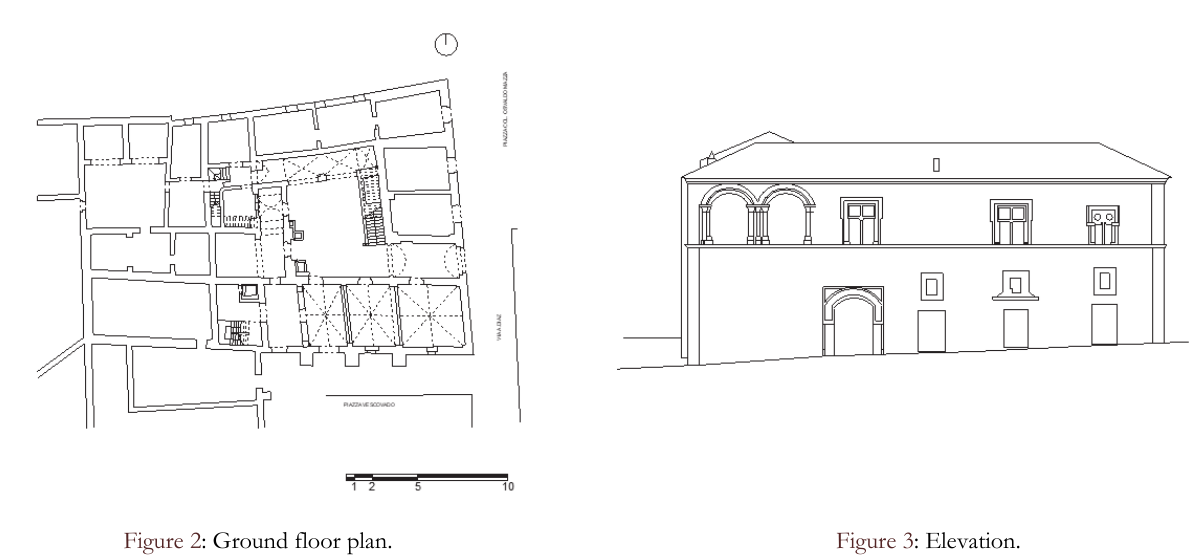
Figure 1: External front views.